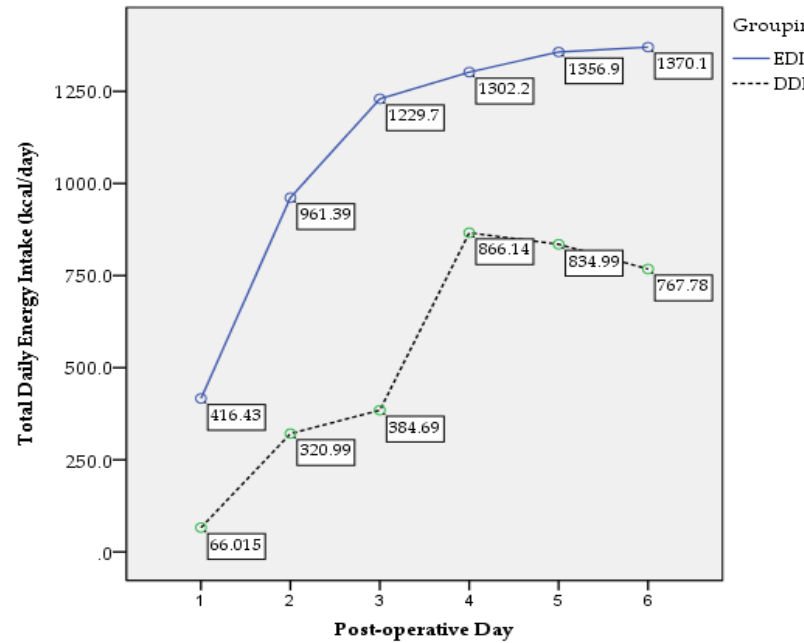
Figure 2. Postoperative total daily energy intake trend.